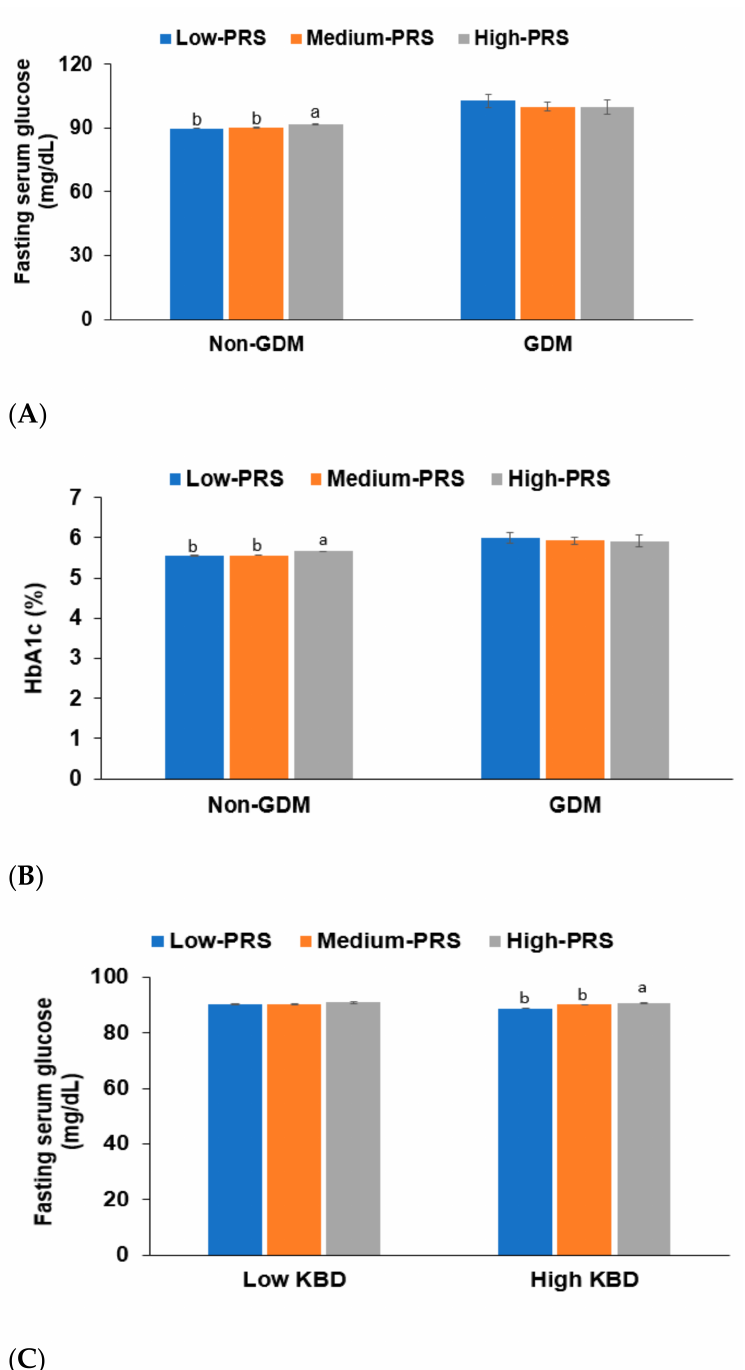
Figure 4. Adjusted means of the fasting serum glucose concentrations and HbA1c contents according to the groups of the low, medium, or high polygenetic risk scores (PRS) of the 5-SNP model. ( A ) Ad- justed means and standard errors of fasting serum glucose concentrations in GDM and non-GDM groups according to the PRS groups of the 5-SNP models from GDM risk. ( B ) Adjusted means and standard errors of fasting serum glucose concentrations in GDM and non-GDM groups according to the PRS groups of the 5-SNP models from GDM risk. ( C ) Adjusted means and standard errors of fasting serum glucose concentrations in Low and High intake of KBD according to the PRS groups of the 5-SNP models from GDM